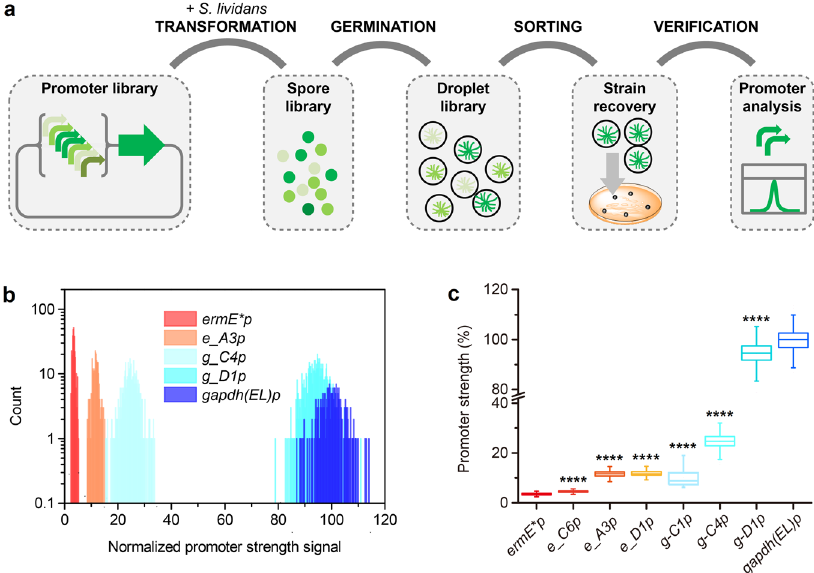
Fig. 4 High-throughput screening of ermE*p and gapdh(EL)p libraries by FADS. a Flow chart of high-throughput screening of promoter libraries by FADS. b Histogram of the fl uorescence strength of droplets containing ermE*p , e_A3p , g_C4p , g-D1p , and gapdh(EL)p . c Relative strength of each engineered promoter compared with that of gapdh(EL)p . Droplets used for b and c analysis includes at least 252 droplets for each sample. Error bars represented the minimum and maximum values. **** p ≤ 0.0001 (Student ’ s two-tailed t 247.9% stronger fl uorescence signals than ermE * p , respectively (Fig. 4b, c, Supplementary Table 1 and Supplementary Data 1),